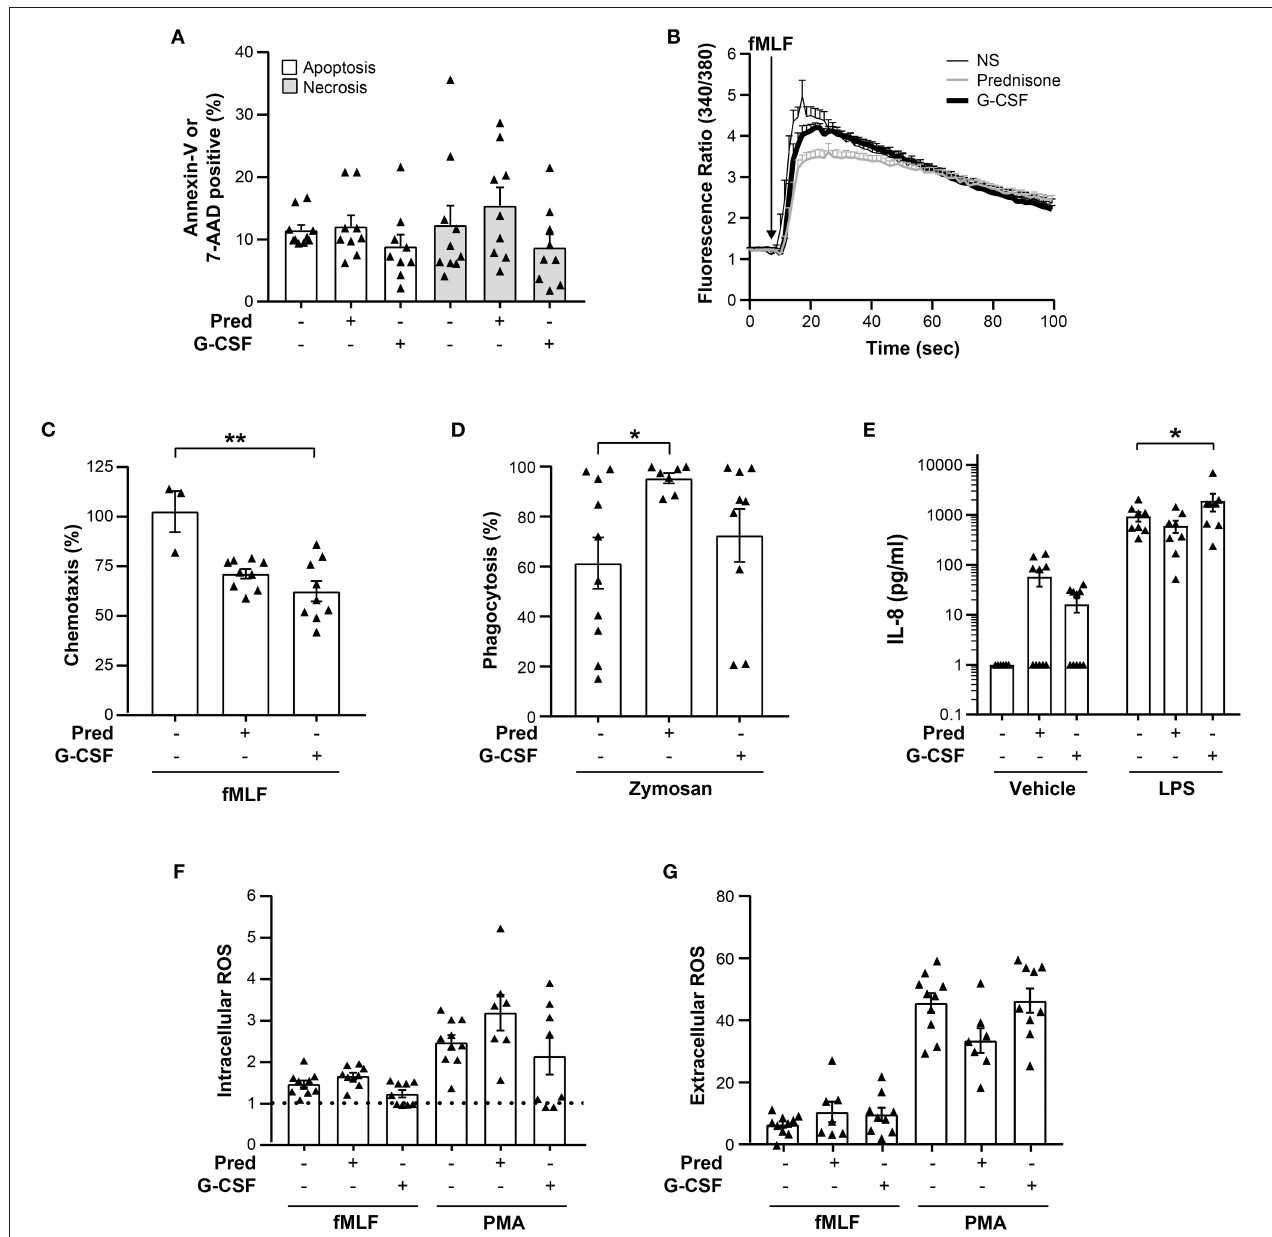
FIGURE 3 | Viability and function of prednisone and G-CSF GC neutrophils. (A) Proportion of apoptosis and necrosis determined by Annexin-V and 7-AAD staining of neutrophils isolated from non-stimulated, healthy donors (-/-) , and prednisone or G-CSF GCs after leukapheresis on the day of collection. (B) Intracellular calcium levels measured with a spectrofluorometer after fMLF stimulation as in “Materials and Methods.” The kinetics of the change in intracellular calcium concentration is shown. For (A,B) , neutrophils of 10 non-stimulated, healthy donors, 9 prednisone and 9 G-CSF GCs were analyzed. (C) Chemotaxis toward fMLF expressed as the maximal proportion of migrated neutrophils [non-stimulated, healthy donors ( n = 3), prednisone ( n = 9) and G-CSF GC donors ( n = 9)]. (D) Phagocytosis of non-opsonized pHRodo Red zymosan conjugated bioparticles is expressed as the proportion of phagocytic neutrophils [non-stimulated, healthy donors ( n = 10), prednisone ( n = 7) and G-CSF GC donors ( n = 9)]. (E) LPS-induced IL-8 release by neutrophils determined by ELISA (n = 8 for all experimental conditions). (F) Intracellular ROS production induced by fMLF [non-stimulated, healthy donors ( n = 10), prednisone and G-CSF GC neutrophils ( n = 9)] or PMA [non-stimulated. healthy donors ( n = 10), prednisone ( n = 7) and G-CSF GC neutrophils ( n = 8)]. Data are expressed as a MFI ratio of stimulated cells/cells incubated in DMSO (diluent). A ratio of 1 corresponds to the absence of an increase in ROS production compared to the DMSO-treated neutrophils (dotted line) . (G) Extracellular ROS production measured with cytochrome c by neutrophils incubated with DMSO, fMLF [non-stimulated, healthy donors ( n = 10), prednisone GCs ( n = 7), G-CSF GCs ( n = 9)] or PMA [non-stimulated, healthy donors ( n = 10), prednisone ( n = 7), G-CSF ( n = 8)] expressed as the concentration of superoxide produced. Statistical analysis: Dunn’s and Dunnett’s multiple comparison test performed to compare neutrophils from non-stimulated, healthy donors with prednisone and G-CSF GC neutrophils, * p -value < 0.05; ** p -value < 0.01.